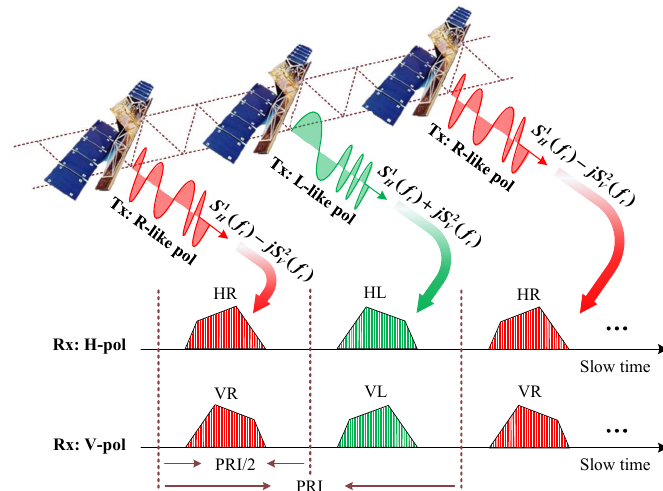
Figure 4. Timing diagram for a hybrid quad-pol SAR system with waveform diversity. In this model, (cid:0) (cid:0) ( f t ) − jS 2 ( f t ) (cid:1) , s ( t ) = F − 1 ( f t ) + jS 2 ( f t ) (cid:1) , where F − 1 s 1 ( t ) = F − 1 S 1 S 1 2 t t H V H V Fourier transform in the range direction.